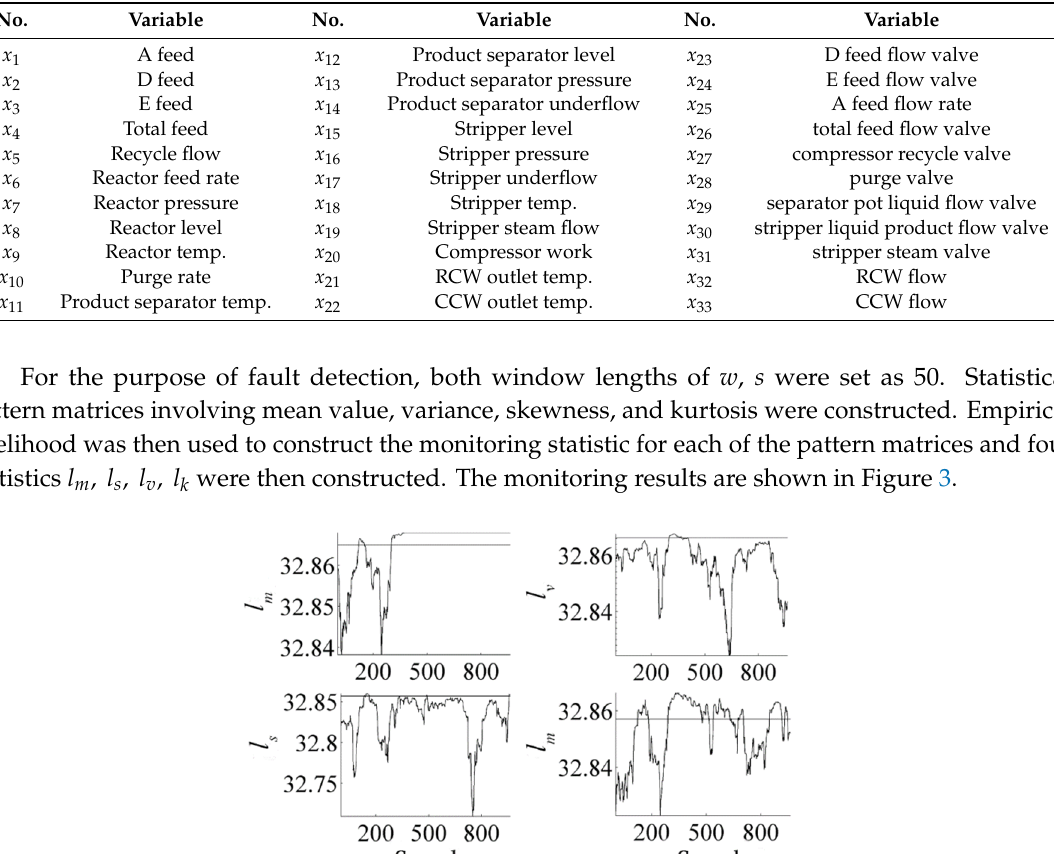
Table 1. Selected process variables for process monitoring. (RCW: reactor cooling water, CCW: condenser cooling water).